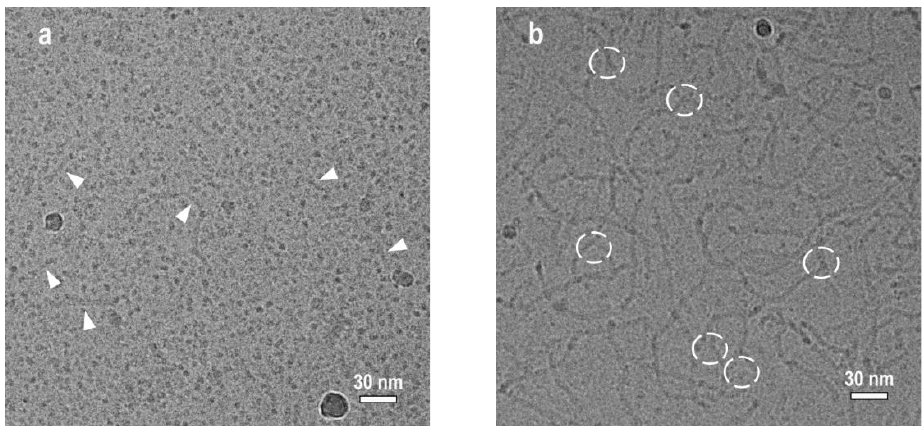
Figure 1. Cryo-TEM images of 94 mM aqueous solutions of potassium oleate in the presence of 67 mM ( a ) and 160 mM ( b ) KCl at pH = 11. Arrows point to rodlike micelles in 67 mM KCl solution. Circles indicate to branching points of WLMs in 160 mM KCl solution.